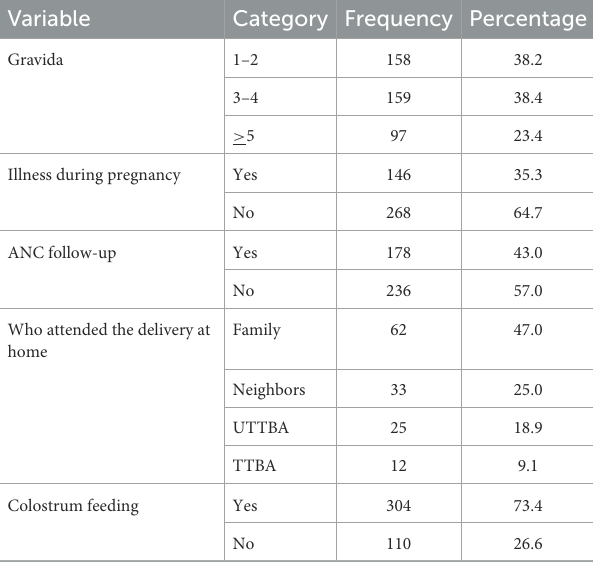
TABLE 1 Socio-demographic characteristics of study participants to assess cultural malpractice during the perinatal period in southwest Ethiopia.